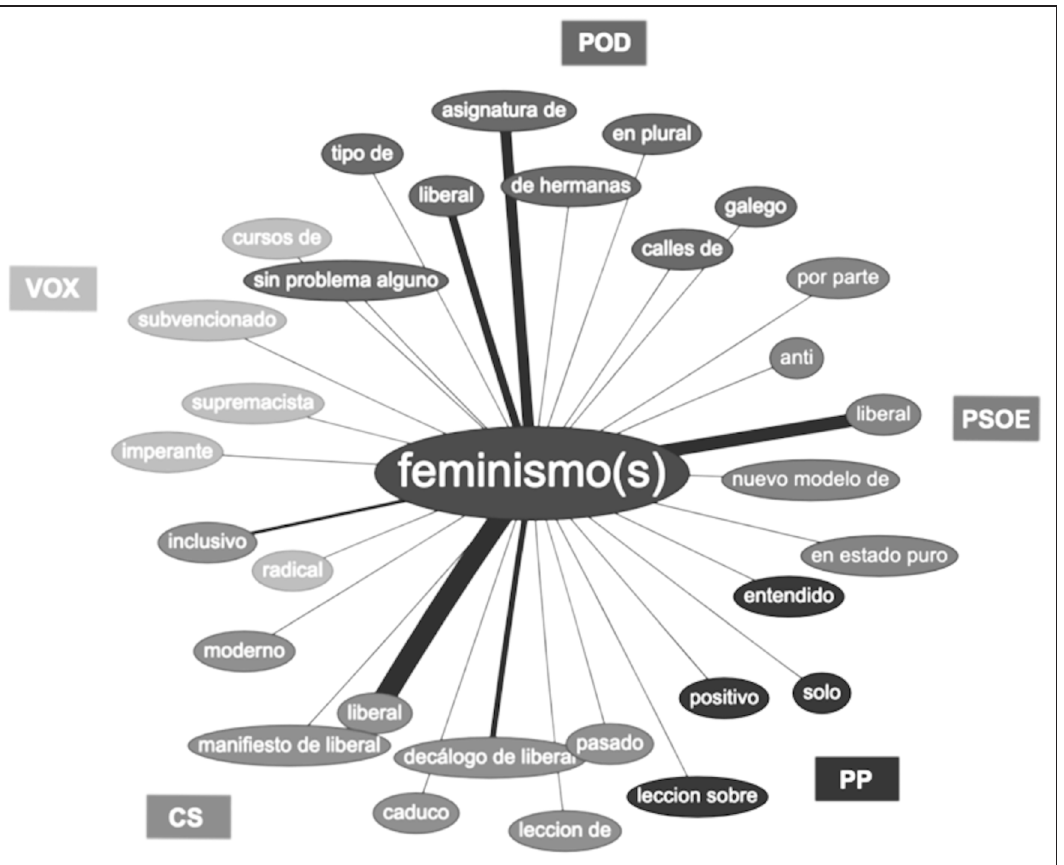
Figure 4: Qualified nouns containing feminismo but those that do tend to deflect critique of the party’s policies in favour of levelling criticism at their left-leaning detractors on the grounds that these entities promote an exclusive and/or negative form of feminism. Tweets containing these qualifiers yield messages in which the PP’s politicians protest the perceived negativity of the party’s critics, rebuffing the lección sobre (lesson on/lecture about) feminism offered by those who criticized the PP’s stance, on the grounds that the PP already espouses a feminismo positivo (positive feminism) that positions women as equal to, rather than against, men.